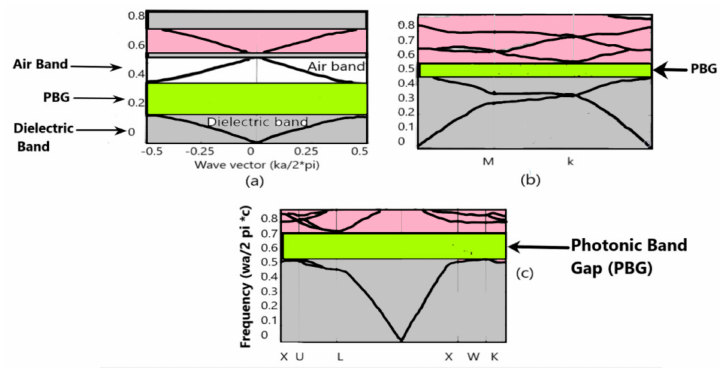
Figure 8. ( a ) Crystal dispersion diagram: shaded prohibited bands, lattice period a, light velocity c. This graphic shows forbidden bands. ( b ) Triangular crystal dispersion diagram: shaded restricted bands; air holes in a high permittivity dielectric form the lattice ( ε = 13) [57]; ( c ) Crystal dispersion diagram. Shaded restricted bands.